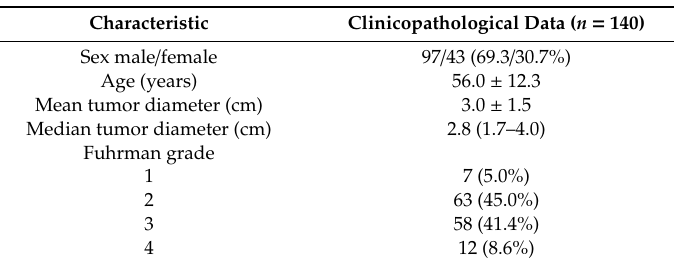
Table 1. Clinical and histopathological